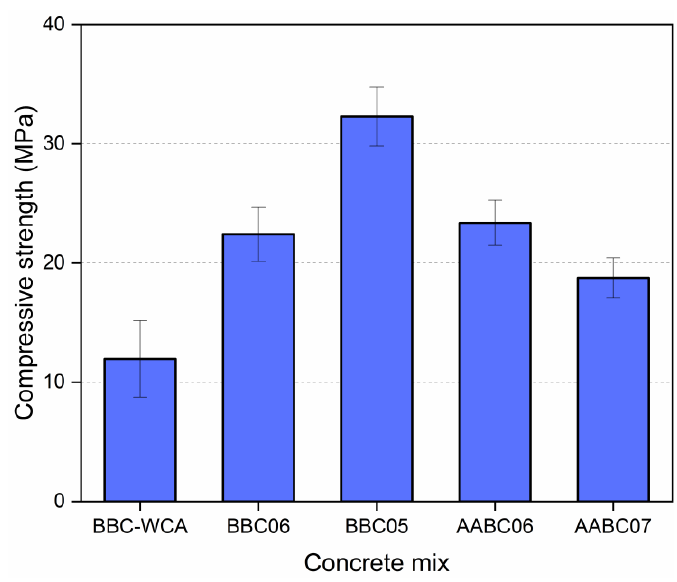
Figure 10. Compressive strength for each concrete mix.